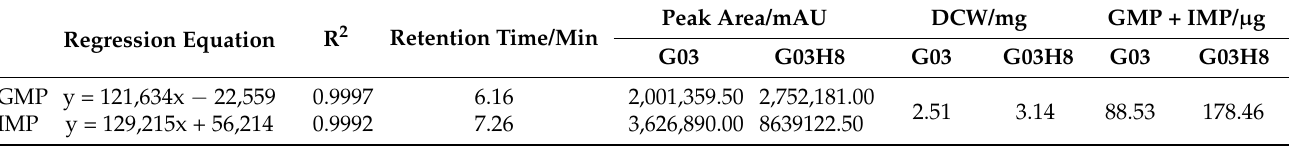
Table 3. Results of flavored nucleotide content about G03 and G03H8.